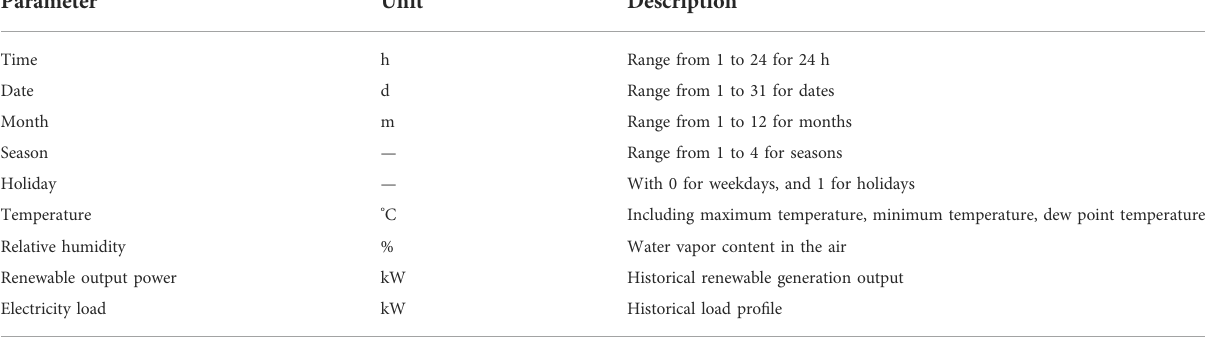
TABLE 1 Parameter set for load demand forecasting.